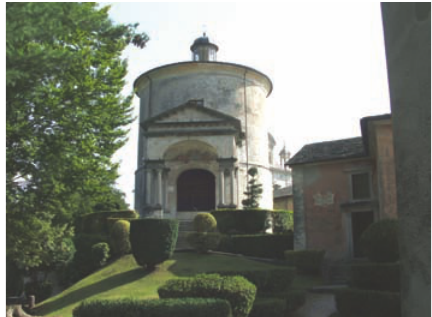
Figure 4: Chapel XVII. The Transfiguration of Christ on Mount Tabor